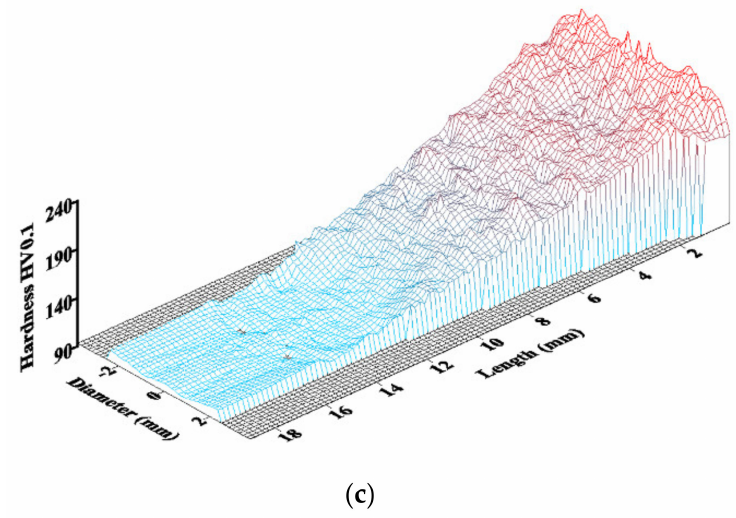
Figure 5. 3D hardness maps: cross-section of the front surface of the original testing specimen ( a ); cross-section of impacted forehead of tested specimen after TAT ( b ); axial longitudinal section of tested specimen after TAT ( c ).